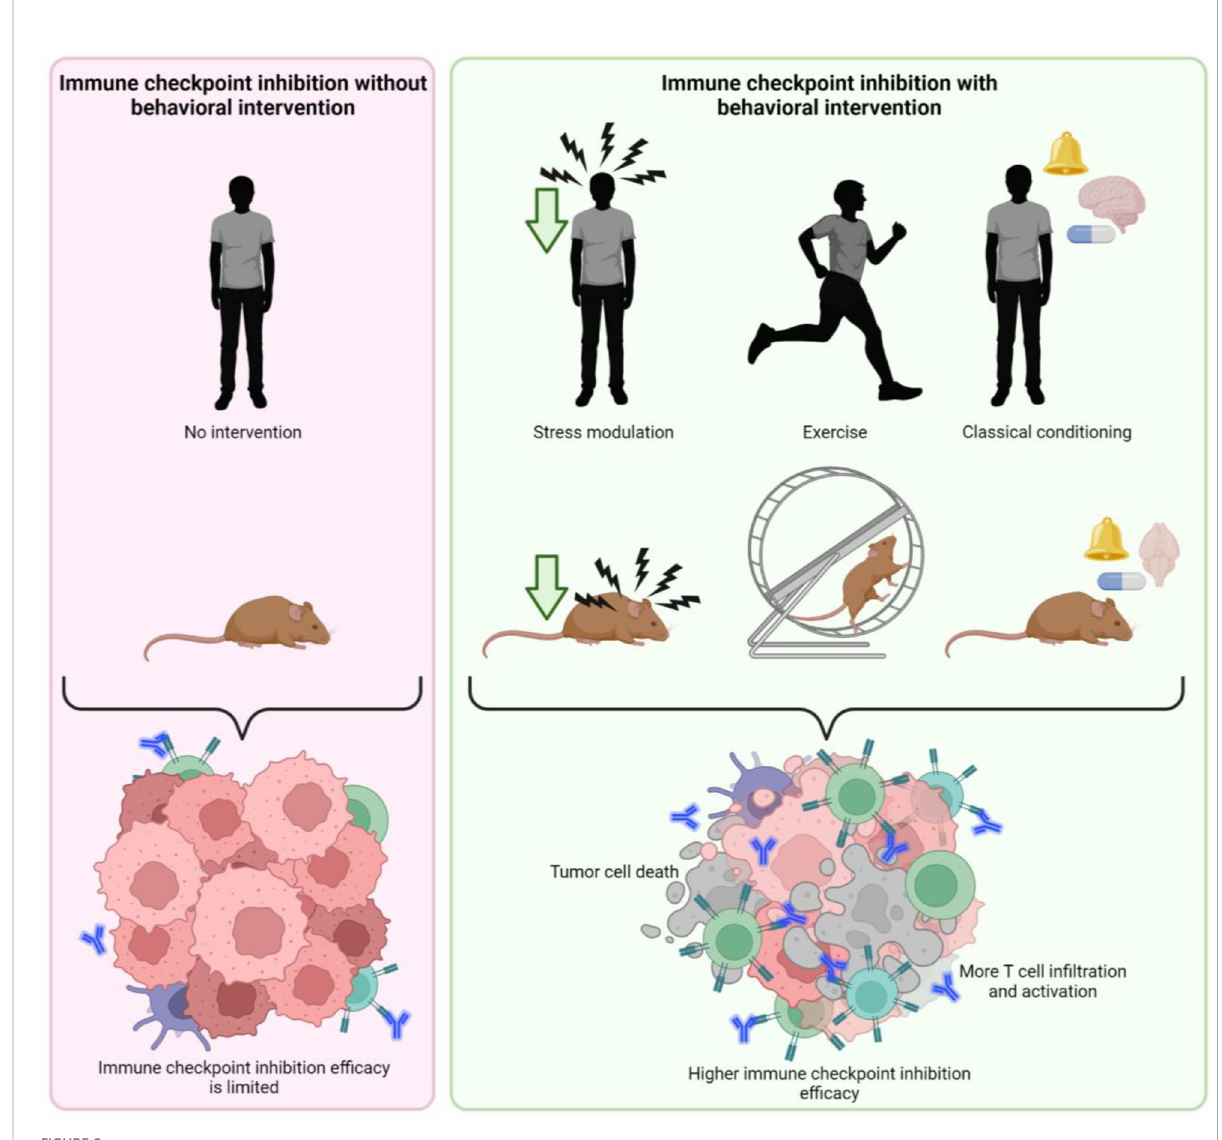
FIGURE 2 Putative effect of behavioral interventions on effectivity of immune checkpoint inhibition therapy. Behavioral interventions such as stress modulation, exercise and classical pharmacological conditioning may enhance the effectivity of immune checkpoint inhibition, promoting tumor cell death by higher T cell in fi ltration and activation created with